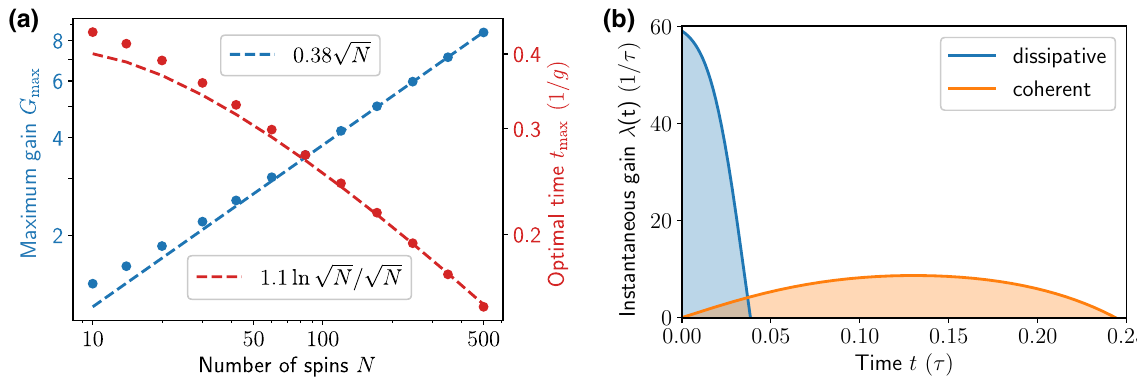
FIG. 9. Coherent spin amplification in a cavity-spin system described by the resonant Tavis-Cummings Hamiltonian (35) with √ ω = ω and initial state e i φ ˆ S x |↑ . . . ↑(cid:6) ⊗ | 0 (cid:6) . (a) The maximum gain G N scaling as in the dissipative case, √ √ cav max follows the same while the optimal evolution time, t max ∝ ln N / N , has a different N dependence than the corresponding time t max ∝ ln N / N in the dissipative case [cf. Fig. 2(a)]. The colored dots correspond to data obtained from solving the Schrödinger equation, while the dashed (cid:5)ˆ (cid:5)ˆ curves show the corresponding large- N scaling behavior. (b) A comparison of the instantaneous gain λ( t ) = [ d S y ( t ) (cid:6) as a S y ( t ) (cid:6) / dt ] / function of time for coherent (orange) and dissipative (blue) amplification protocols with N = 120 spins. The time scale τ (which is N independent) is 1 / g and 1 /(cid:5) for the coherent and dissipative cases, respectively. The maximum gain G max shown in (a) corresponds to the integral of λ( t ) between t = 0 and t = t max (i.e., the shaded regions), which are nearly equal in both cases. All numerical results presented here for the unitary scheme are obtained by numerical integration of the Schrödinger equation with Hamiltonian